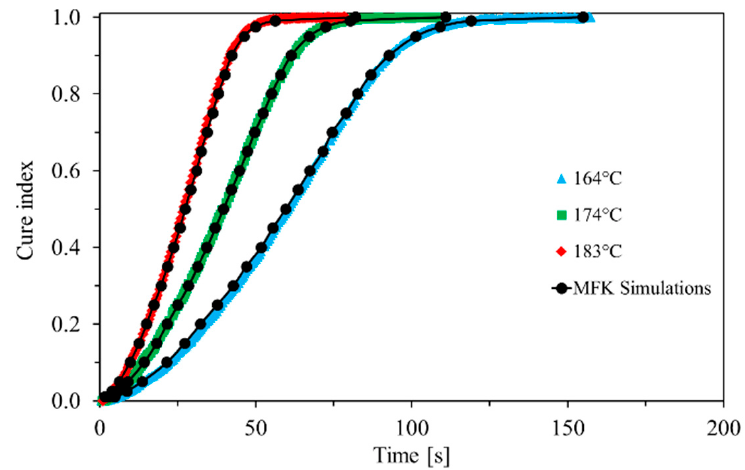
Figure 6. Comparison of isothermal time courses based on iso-conversional calculations (intercon- nected black dots) and experimental data (red, green and blue dots).